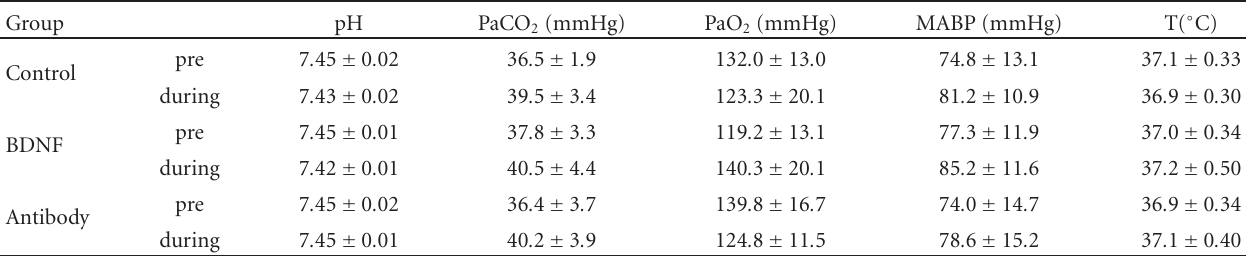
Table 2: Physiological parameters per- and during